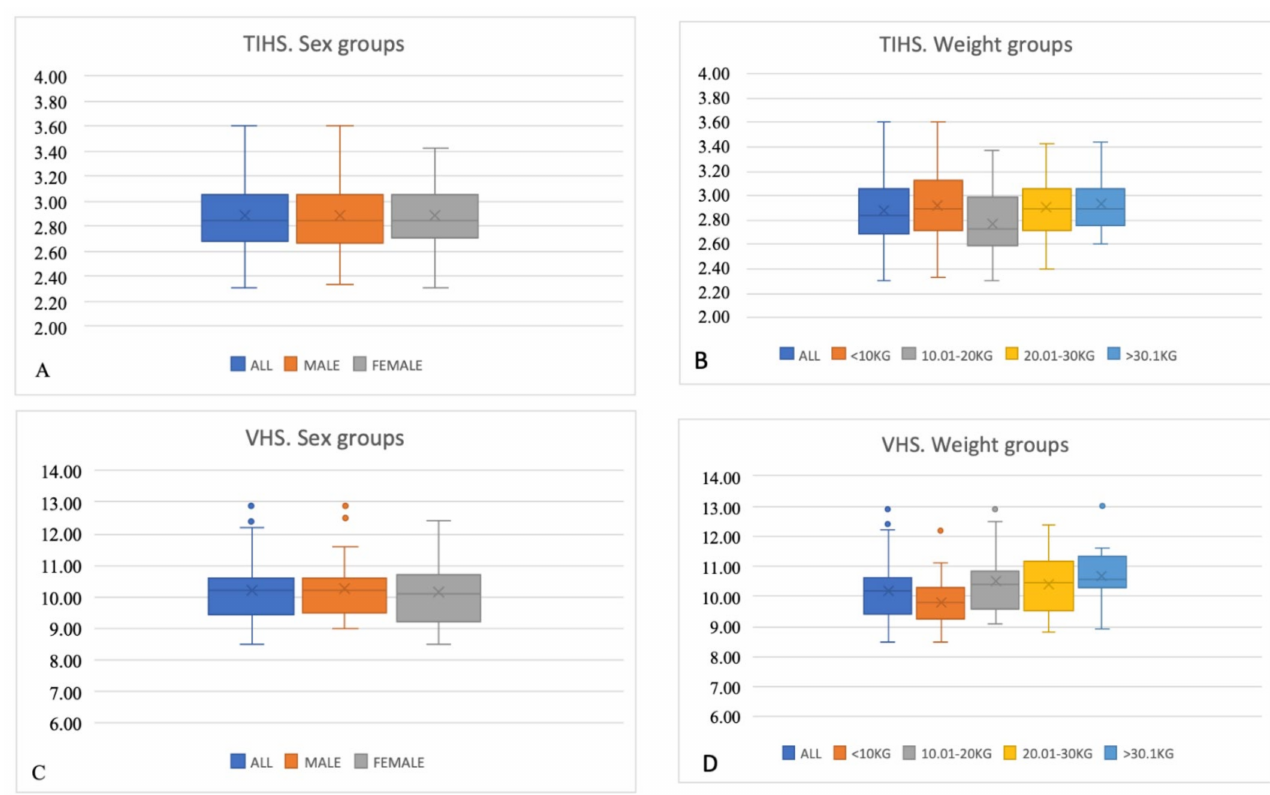
Figure 2. Box plots illustrating TIHS ( A , B ) and VHS ( C , D ) for the general population, sex groups (male and female), and body weight groups ( ≤ 10 kg, 10.01–20 kg, 20.01–30 kg, and ≥ 30.01 kg). Dots represent outliers.